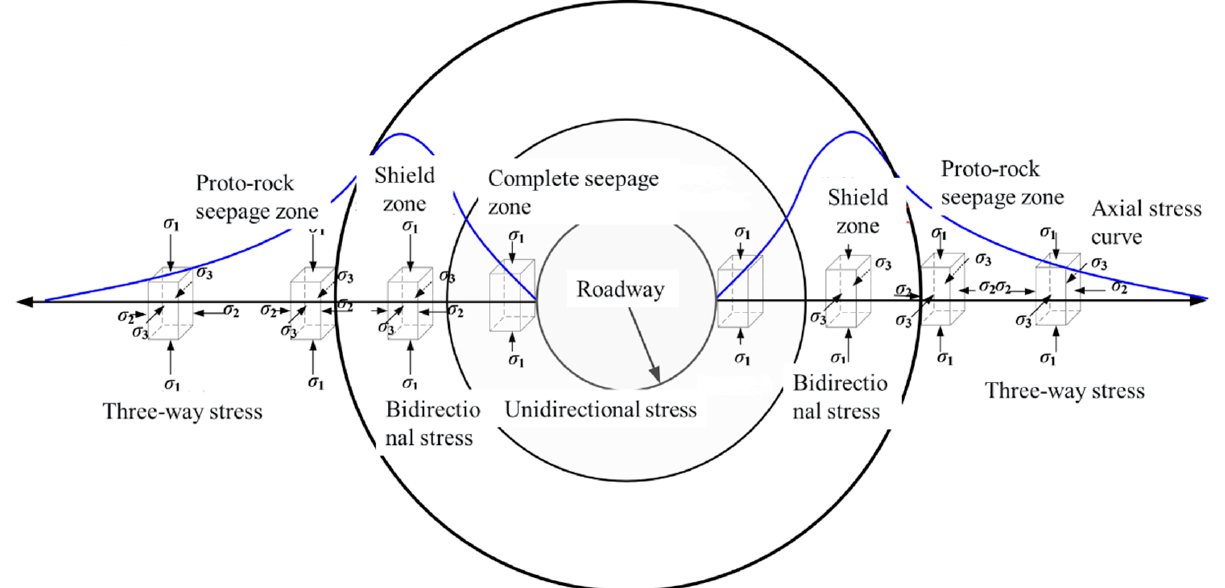
Figure 2. Schematic diagram of gradient failure structure of surrounding rock.